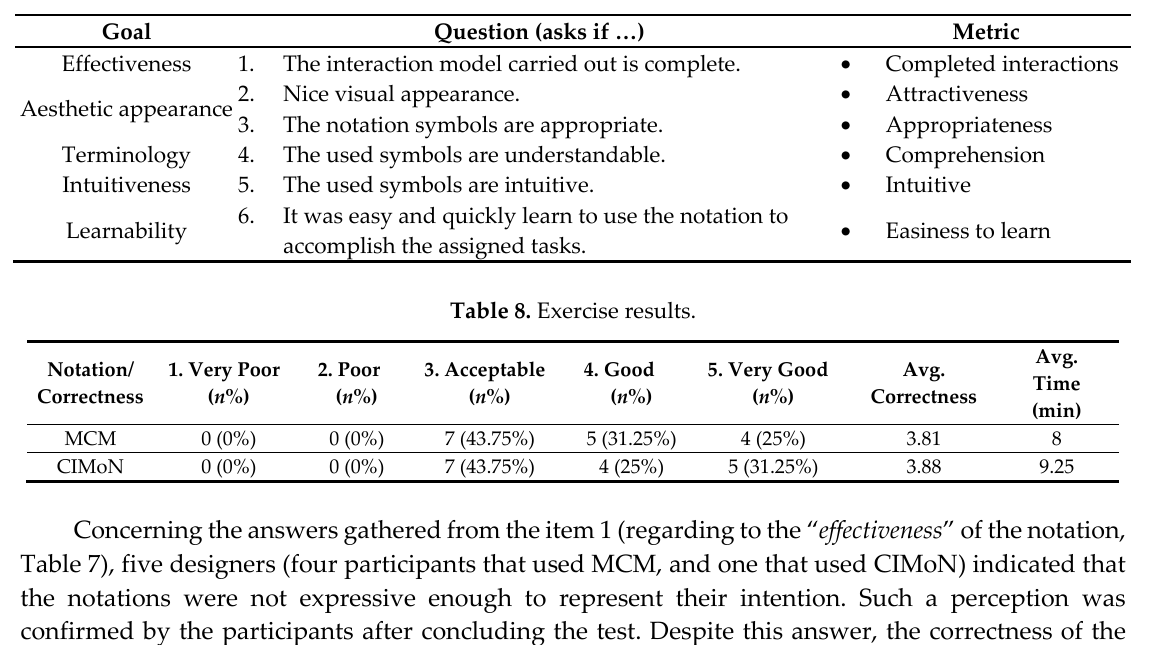
Table 7. Usability questions and metrics.